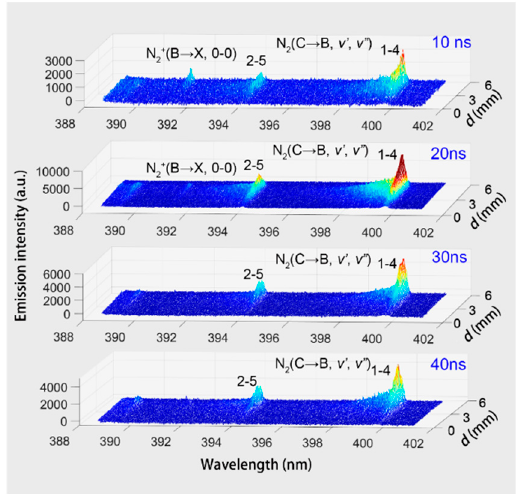
Figure 5. Spatial resolved spectra in the range of 389–401 nm at four different times.